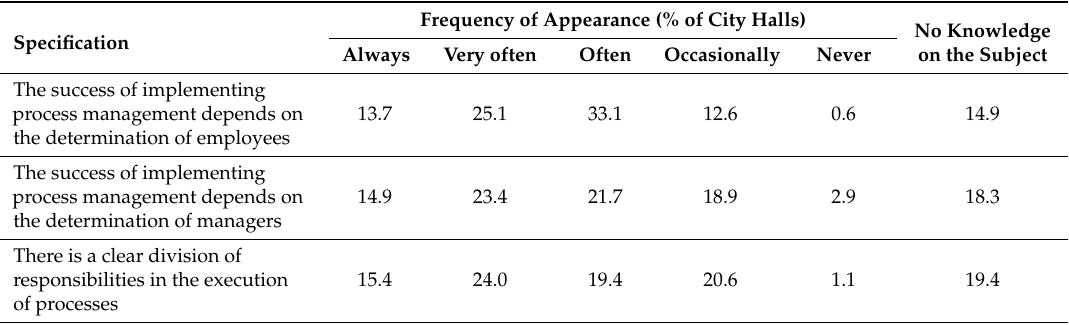
Table 3. The role of employees in the implementation of process management (n = 174).